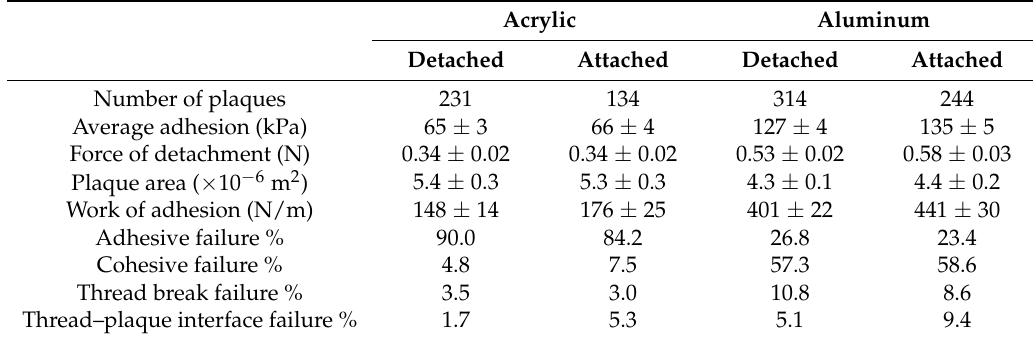
Table 1. Adhesion results of attached versus detached byssus on acrylic and aluminum.